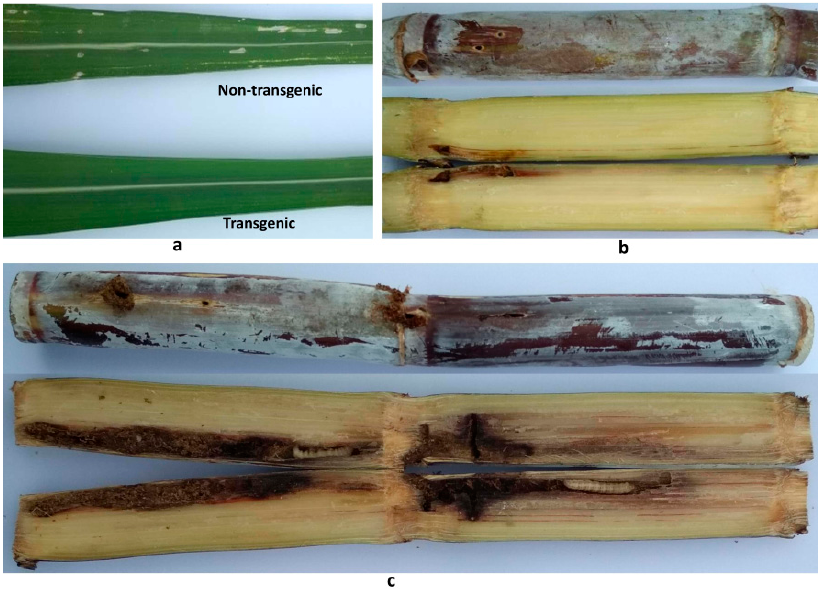
Figure 6. Stem borer damage in sugarcane under natural field conditions: ( a ) symptoms of the transgenic and non-transgenic sugarcane leaf; ( b ) symptoms of the transgenic sugarcane stem (only in cortex); and ( c ) symptoms of non-transgenic sugarcane stem.